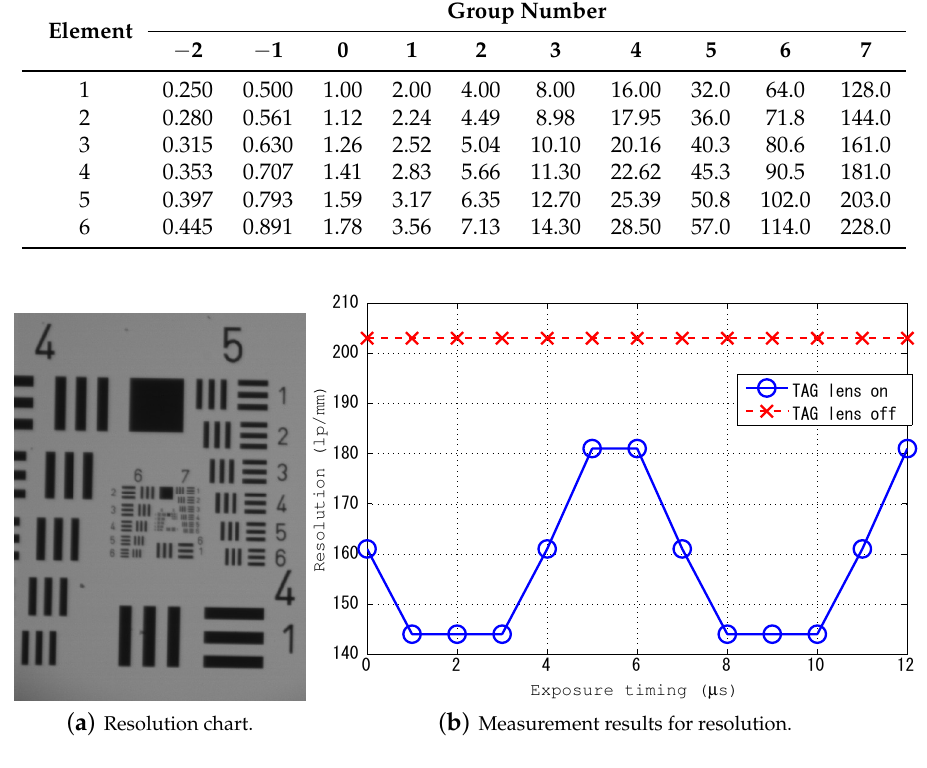
( b ) Measurement results for resolution. Figure 7. Resolution chart and measurements results.